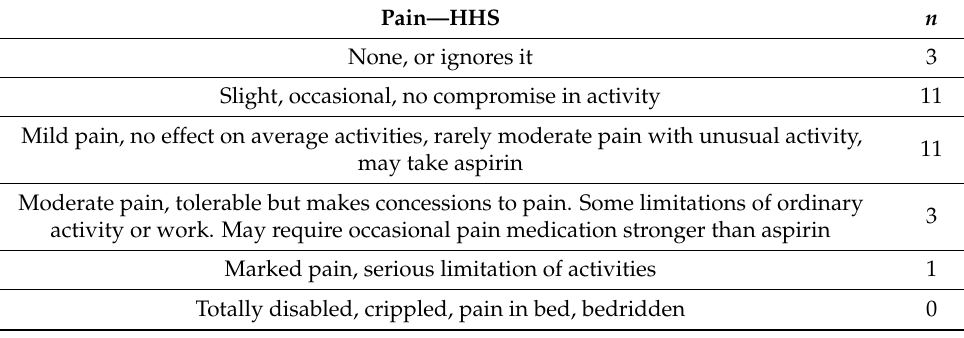
Table 3. Pain intensity according to the HHS. Pain—HHS n None, or ignores it 3